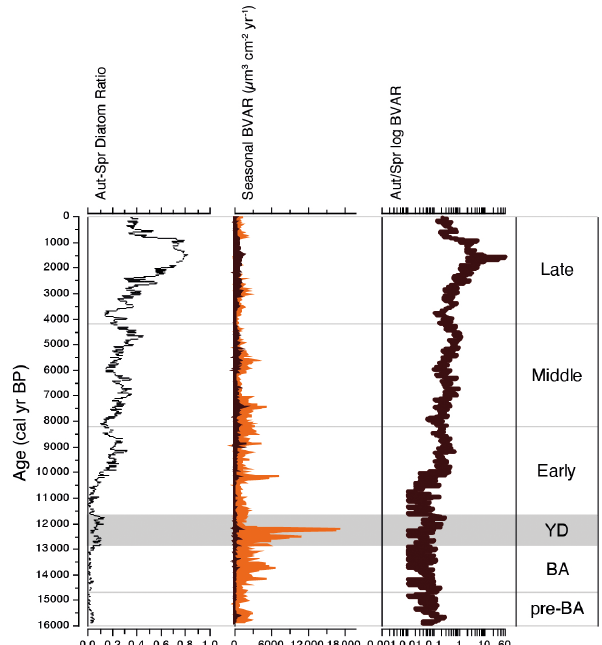
Figure 6. Stratigraphical profile showing trends in palaeoproduc- tivity over the past ca. 16kyr: the proportion of diatoms that bloom in the autumn versus those that bloom in the spring; esti- mates of palaeoproductivity derived from spring (orange) and au- tumn (dark brown) diatom biovolume accumulate rates (BVAR µm 3 cm − 2 yr − 1 ); and log-transformed ratio of autumnal/spring